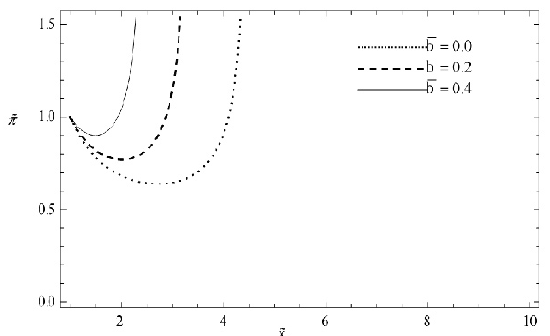
Figure 7. The growth of shock strength ( γ = 5/3.